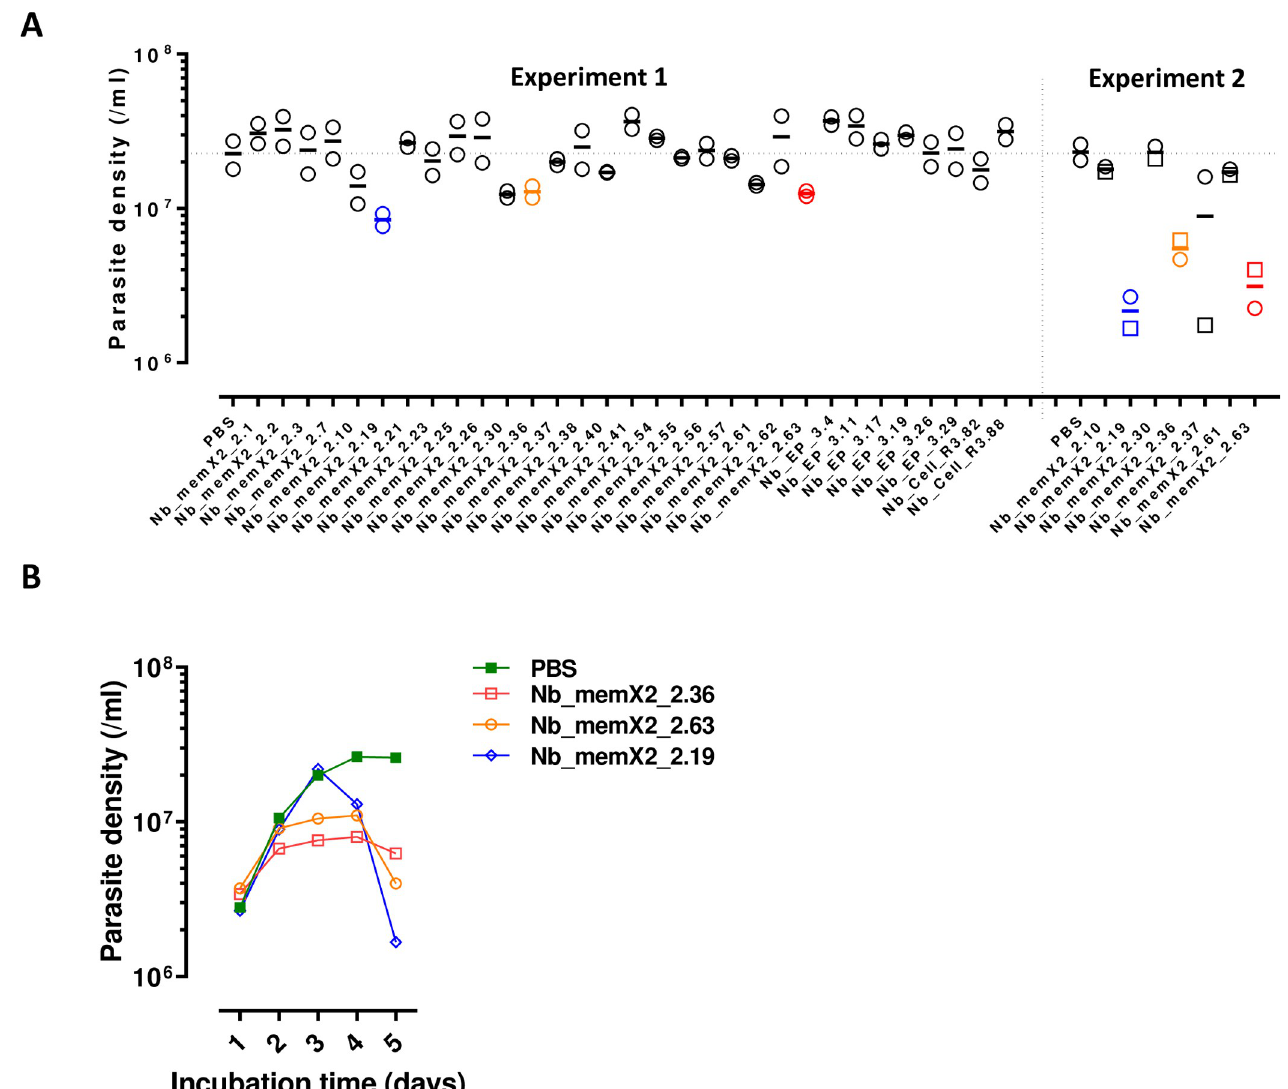
Fig 3. In vitro toxicity assay with individually purified anti-procyclic Nbs. ( A ) two separate experiments evaluating the toxicity after respectively 4 days (experiment 1; 10 μ g/ml Nb, technical duplicates) and 5 days [experiment 2; 12.5 μ g/ml (circles) and 25 μ g/ml Nb (squares)]. Nbs with consistent anti- trypanosomal activity (Nb_memX2_2.19, Nb_memX2_2.36, Nb_memX2_2.63) are indicated in colour. ( B ) Parasite growth kinetics in cultures supplemented with 25 μ g/ml of the respective anti-trypanosomal Nbs (Nb_memX2_2.19, Nb_memX2_2.36, Nb_memX2_2.63). Presented data are representative for at least two independent